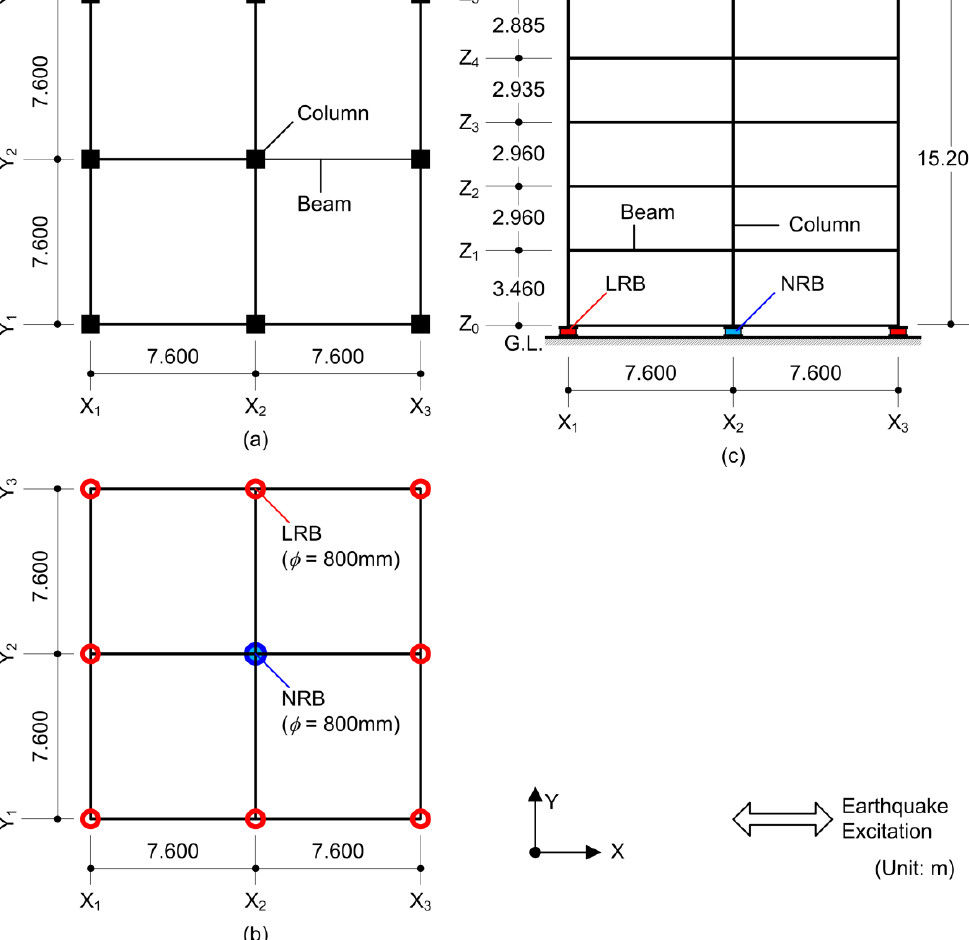
Figure 1. Simplified structural plan and elevation (Model-05): ( a ) plan of levels Z 1 to Z 5 , ( b ) plan of level Z 0 , and ( c ) elevation of frame Y 2 .